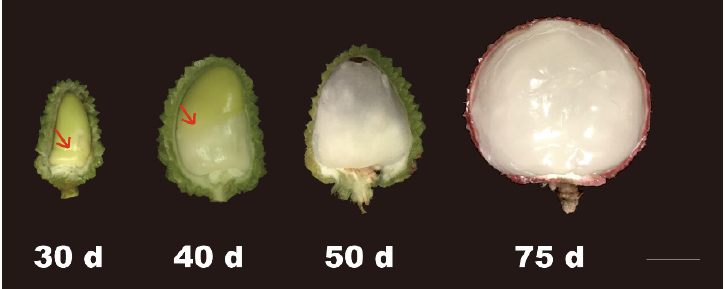
Figure 1. Phenotype changes of aril development at different stages. The arrowhead refers to the aril. Bar = 1